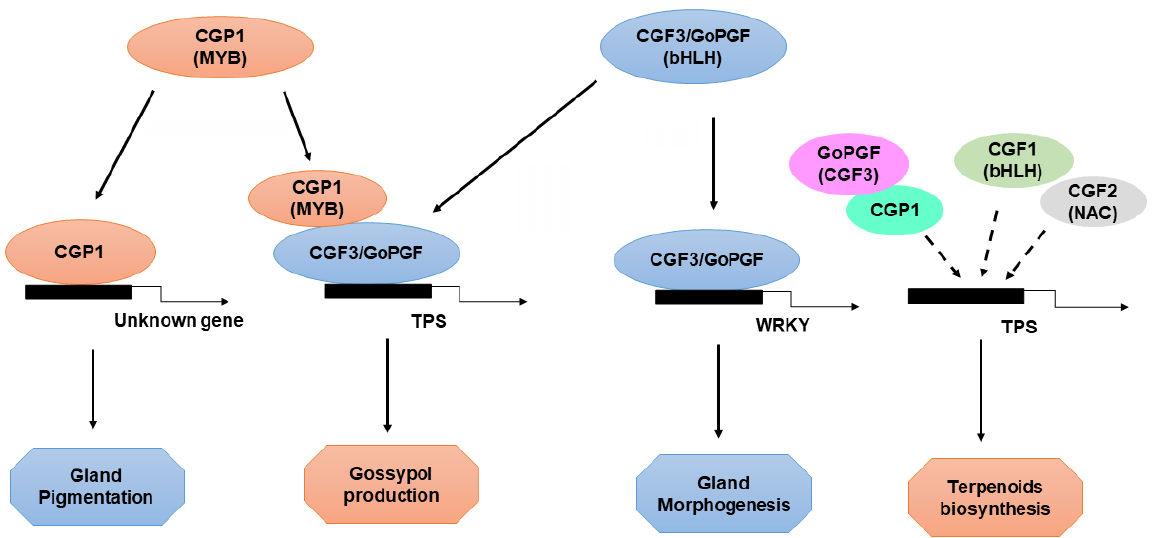
Figure 3. Regulation of gland formation and gossypol biosynthesis. The regulation of gland formation and gossypol biosynthesis. GoPGF protein, as a master regulator, controls the specification and differentiation of gland cells by regulating the expression of downstream genes. CGF2, a NAC transcription factor, also plays an important role in gland development and terpenoid biosynthesis. Moreover, GoPGF interacts with CGP1, an R2-R3 MYB transcription factor, to regulate the